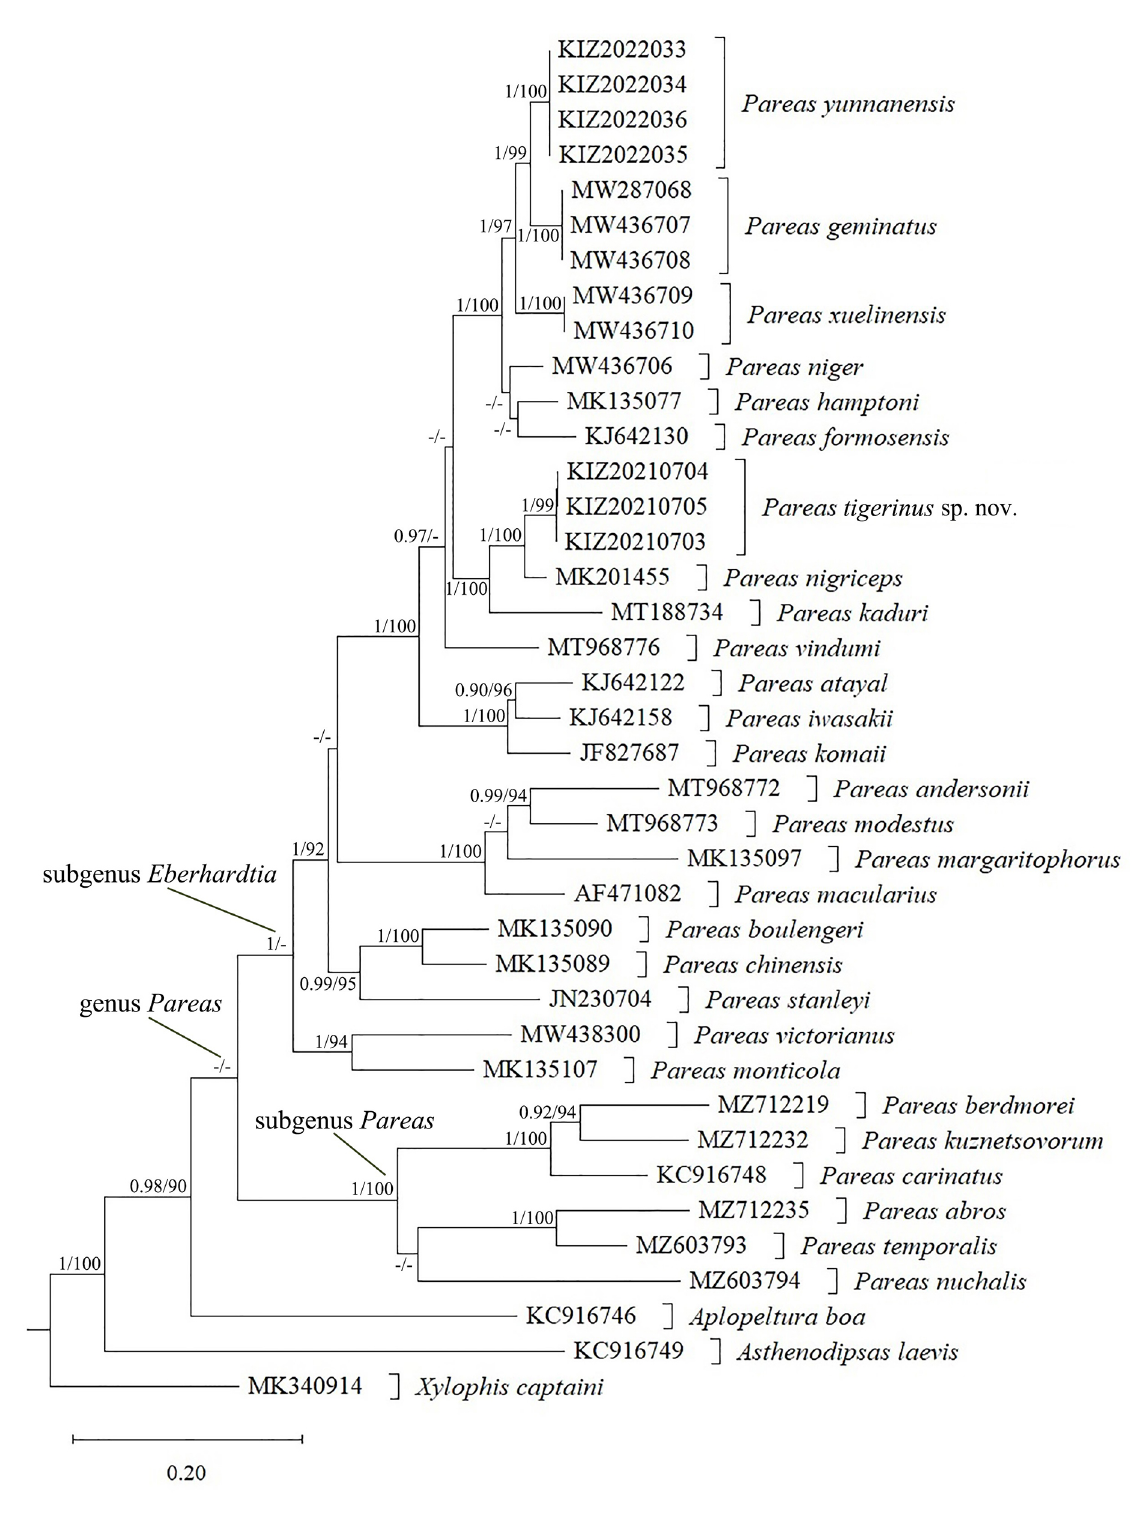
Fig. 1. Bayesian phylogeny tree of Pareas Wagler, 1830 inferred from cyt b sequences. Node numbers before slashes indicate BPP (values below 0.90 are not shown) and numbers after slashes indicate UFB (values below 90 are not